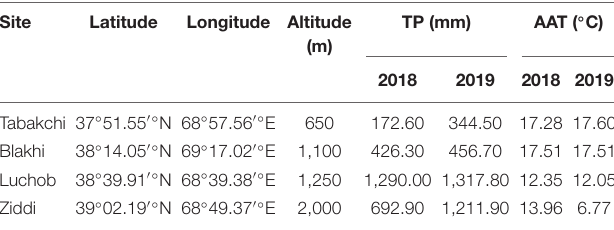
TABLE 1 | The location of the four experimental sites and the total precipitation and annual average temperature among the four sites. Site